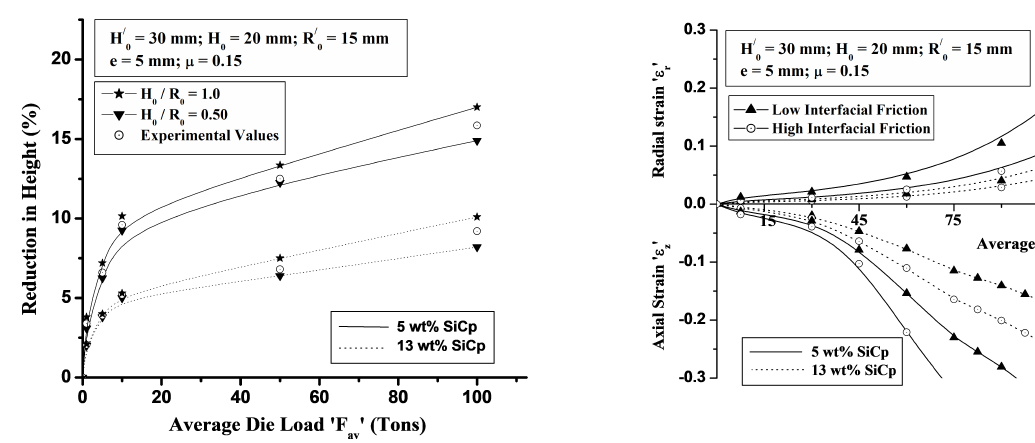
Fig. 9. Variation of Radial & Axial